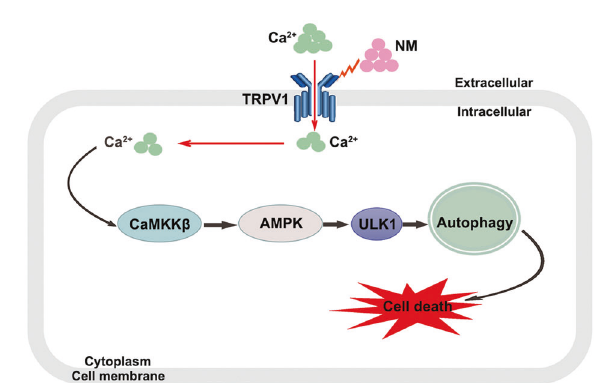
Fig. 9 Regulation of NM-induced autophagy in keratinocytes. NM- induced keratinocyte cell death by overactivating autophagy via the proposed signaling pathways: NM induces TRPV1 expression, which is followed by an increase of intracellular Ca 2 + content, thereby activating CaMKK β , subsequently increasing AMPK and ULK1 activity and ultimately inducing